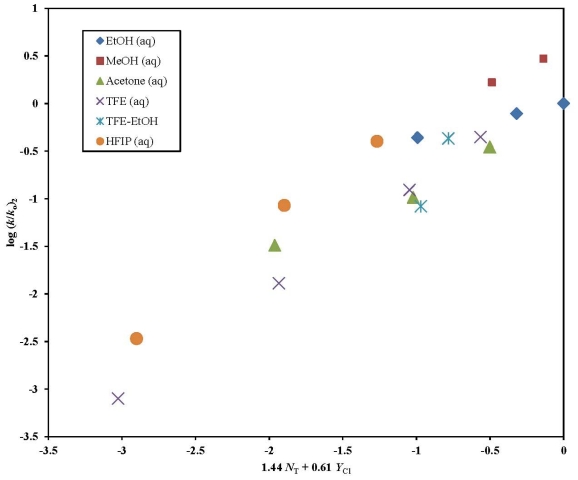
The plot of log (k/ko) for 2-methoxyphenyl chloroformate (2) against 1.44 NT + 0.61 YCl.